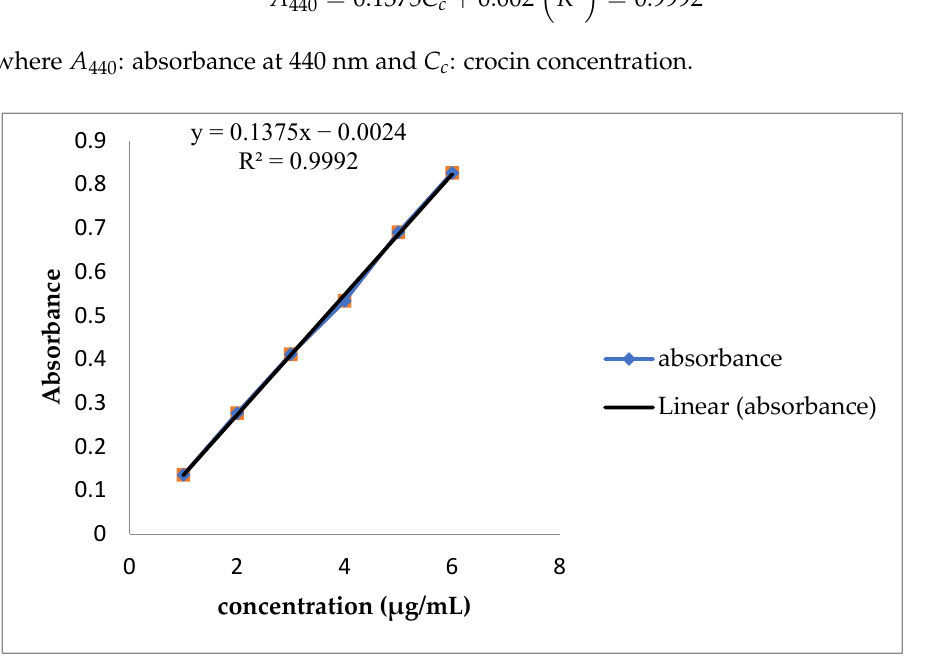
Figure 1. Standard curve of crocin.